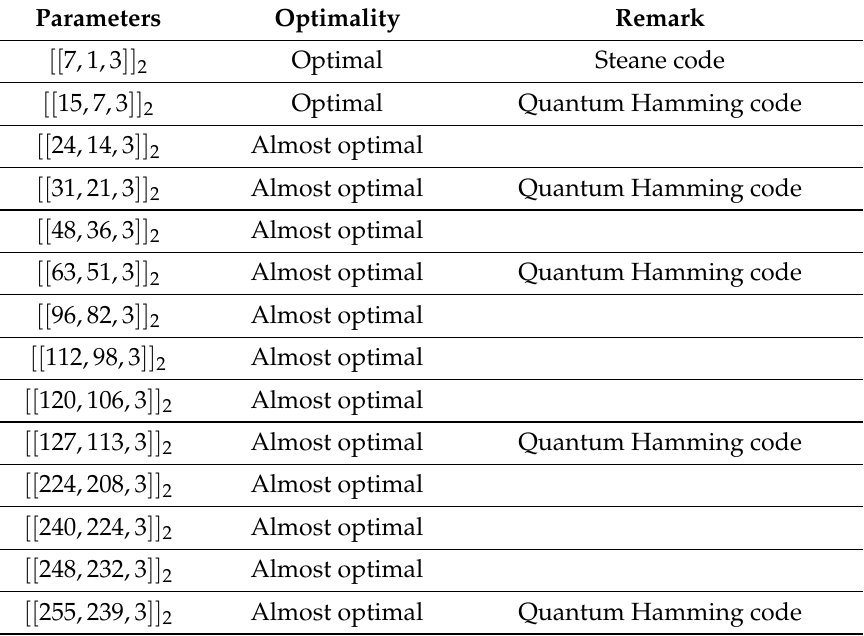
Table 5. Binary quantum codes with minimum distance three from Theorem 4.